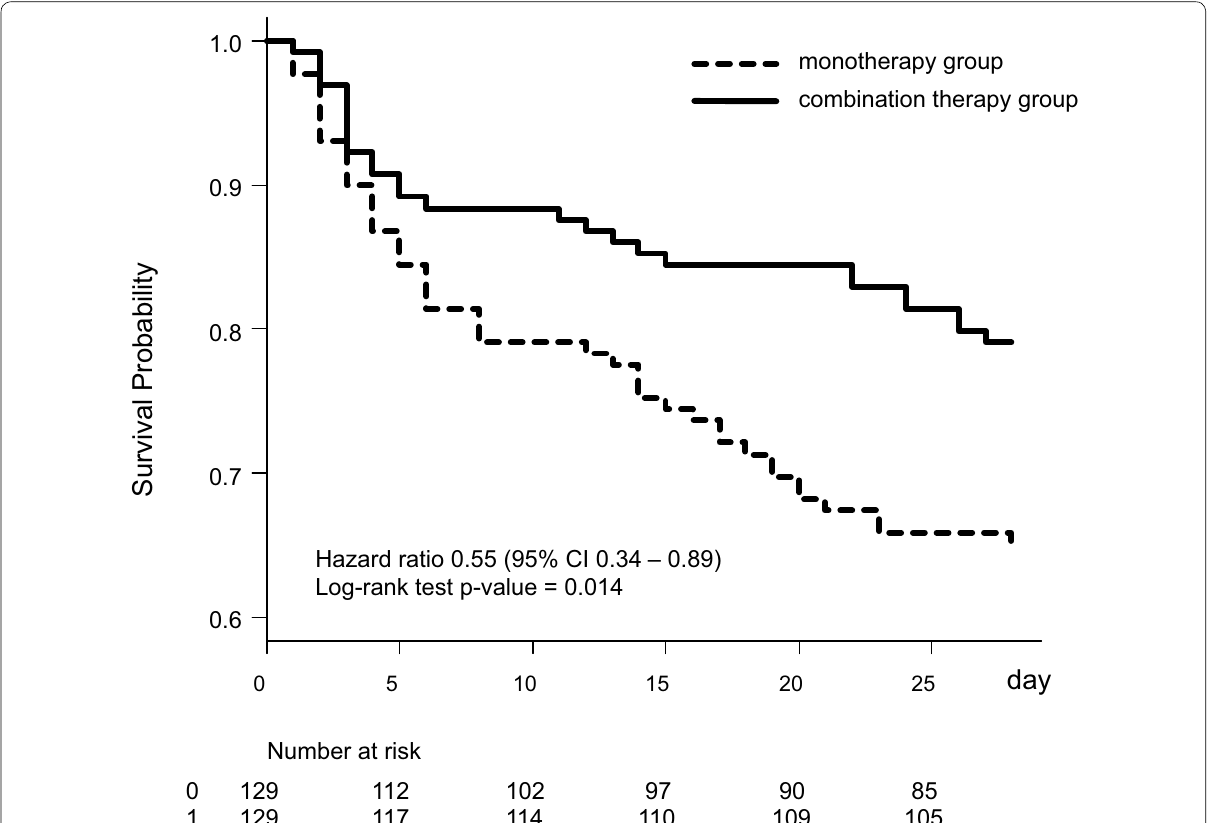
Fig. 2 Survival plots for patients in the propensity score-matched combination therapy and monotherapy groups. The 28-day survival rate was significantly higher in the combination therapy group (79.8%) than in the monotherapy group (70.0%) ( P (0.34–0.89).